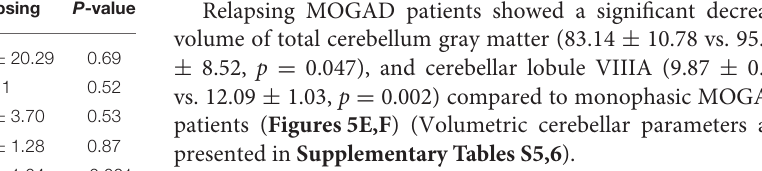
Duration from first Treatment (months) episode to MRI (months)